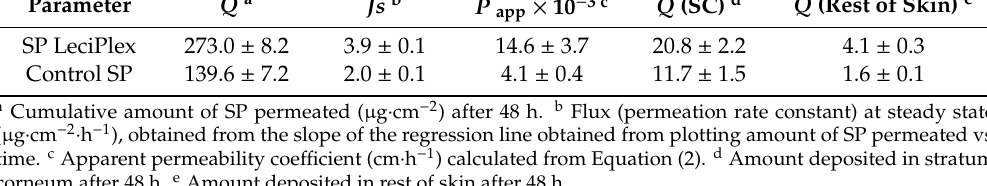
Table 4. Ex vivo permeation parameters of SP from di ff erent formulations through rat skin.